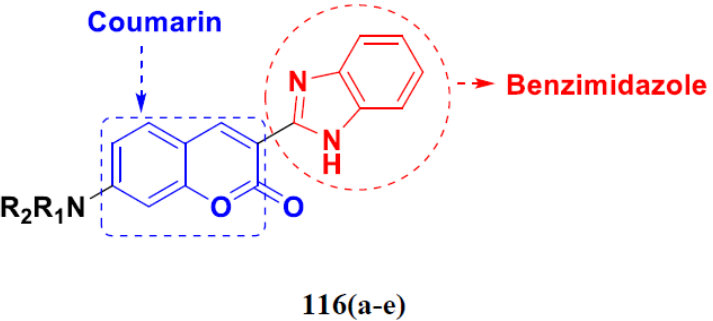
Figure 111. Structure of coumarin ‐ benzimidazole derivatives 116 ( a – e ). Table 98. In vitro cytotoxic activities of coumarin-benzimidazole hybrid compounds 116 ( a – e ). Compound